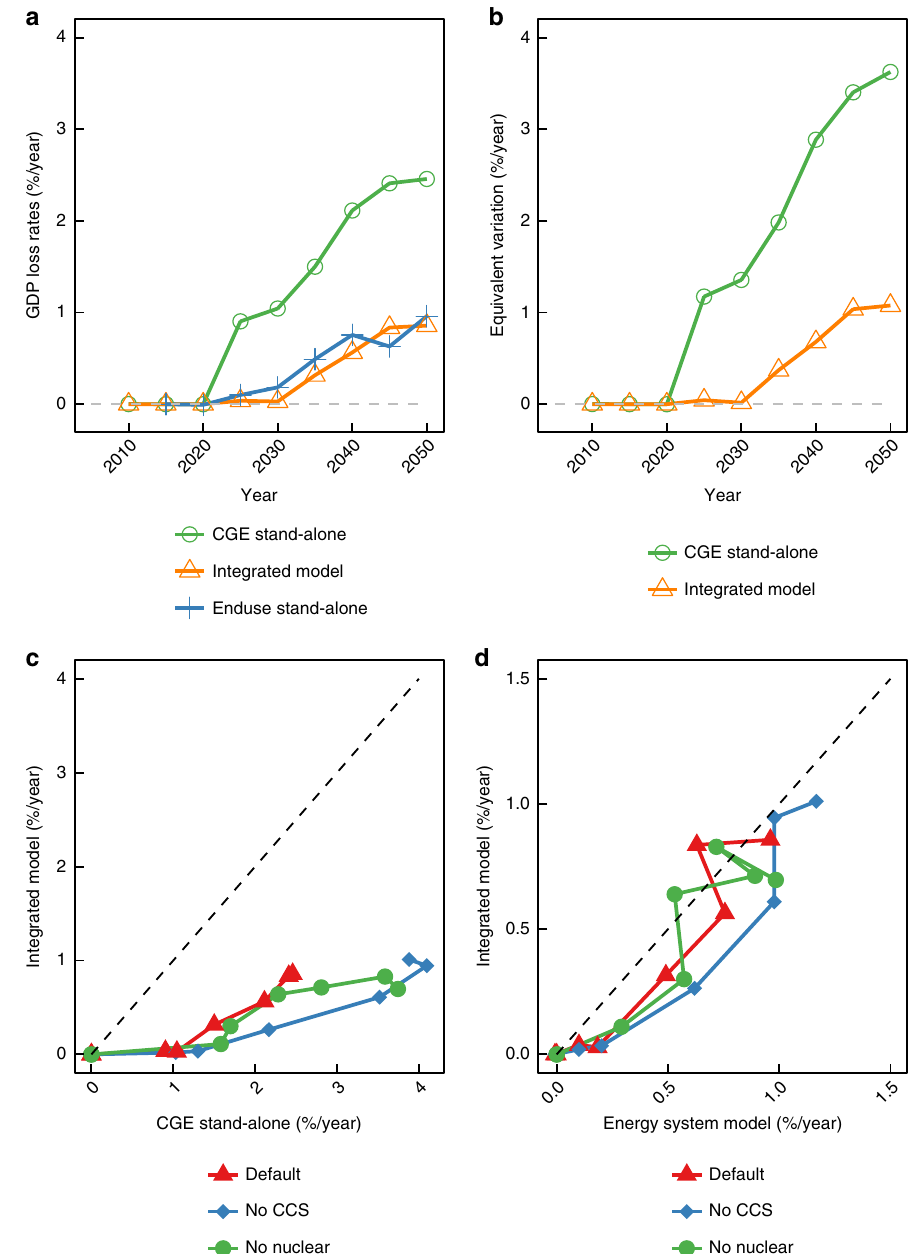
Fig. 3 Climate change mitigation cost. a , b Time-series mitigation cost AIM/CGE results are represented as GDP loss rates and equivalent variation change rates relative to baseline scenarios. AIM/Enduse results are expressed as additional energy system costs of GDP relative to baseline scenarios. c , d 5-year mitigation costs with varying technological availability; c illustrates the relationship of GDP losses in the CGE stand-alone and integrated models, and d shows GDP losses in the integrated model and additional energy system costs in AIM/Enduse. The energy system model results shown here correspond to Enduse_results1 in Supplementary Fig.